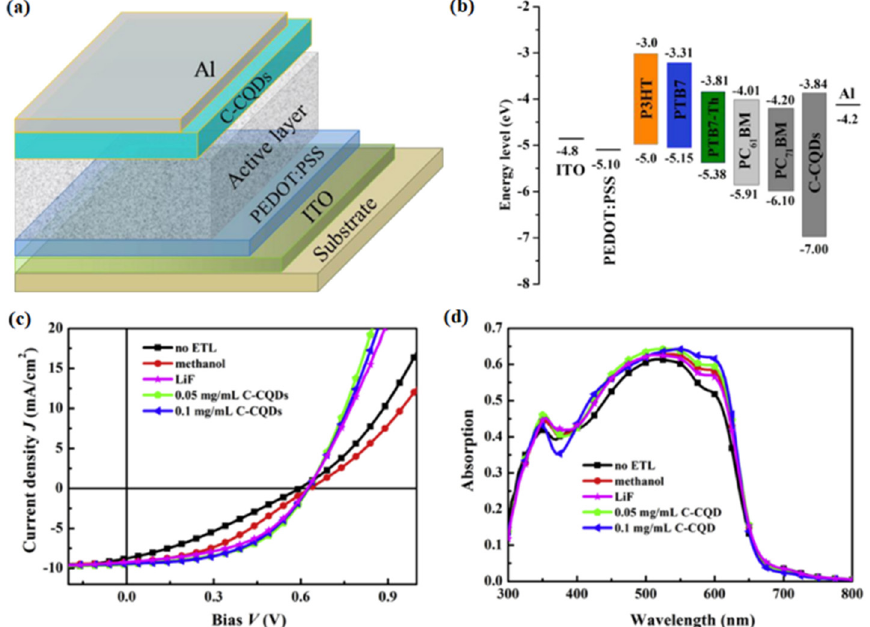
Figure 12. ( a ) The structure of the PSCs. ( b ) The energy level diagram of various function layers. ( c ) The J–V curves of P3HT:PC 61 BM devices. ( d ) The EQE spectra of P3HT:PC 61 BM devices [67]. Copyright 2016, Carbon .